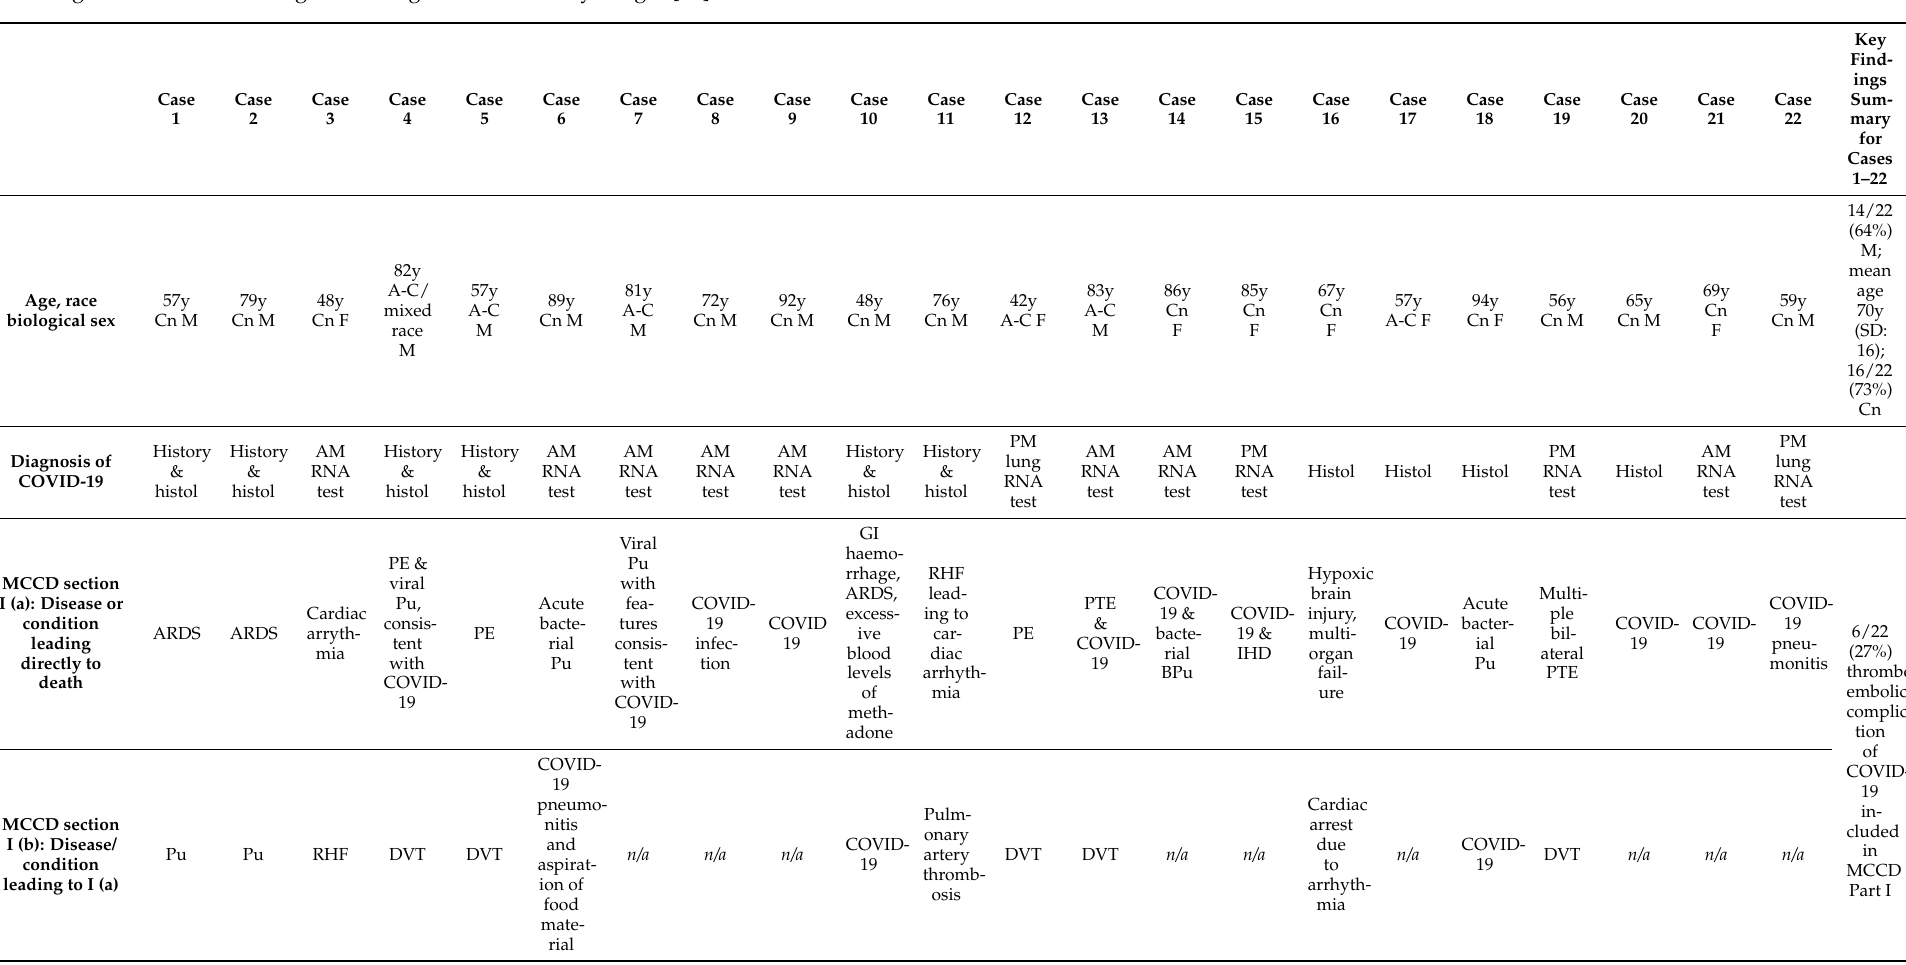
Table 1. Key findings of 22 post-mortem examinations carried out on confirmed or suspected cases of COVID-19 infection between March 2020 and February 2021. Centiles for heart weights were derived in light of biological sex and body weight